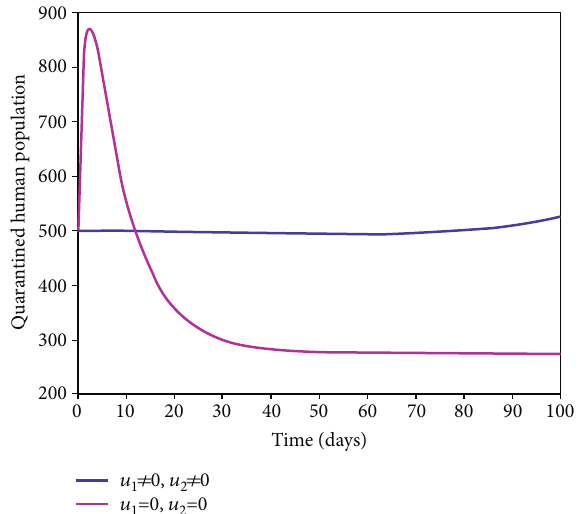
Figure 18: The pro fi le of optimal controls u